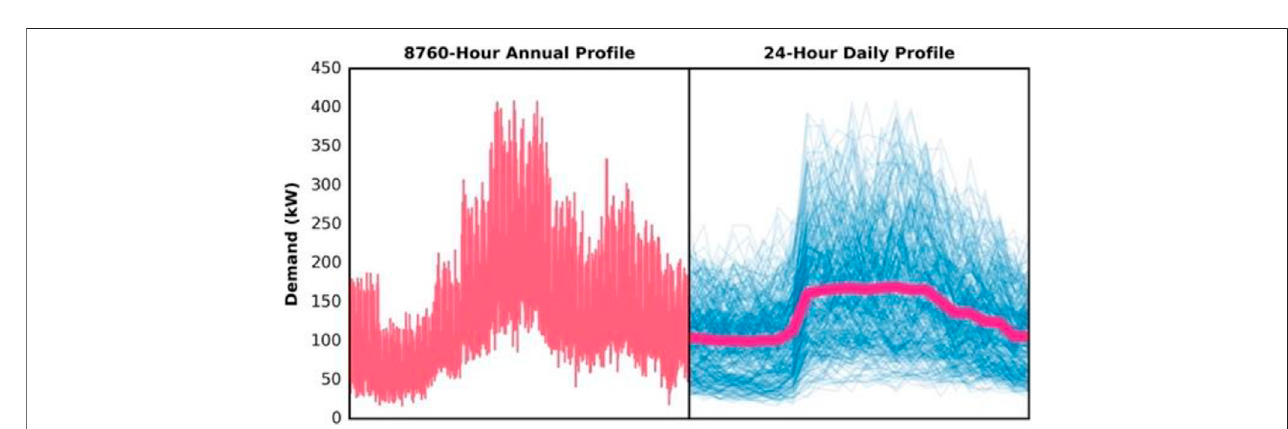
FIGURE 5 | Building annual and daily electricity demand pro fi le.